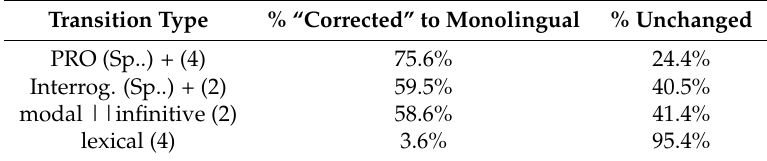
Table 6. Results of memory-loaded repetition experiment ( N =